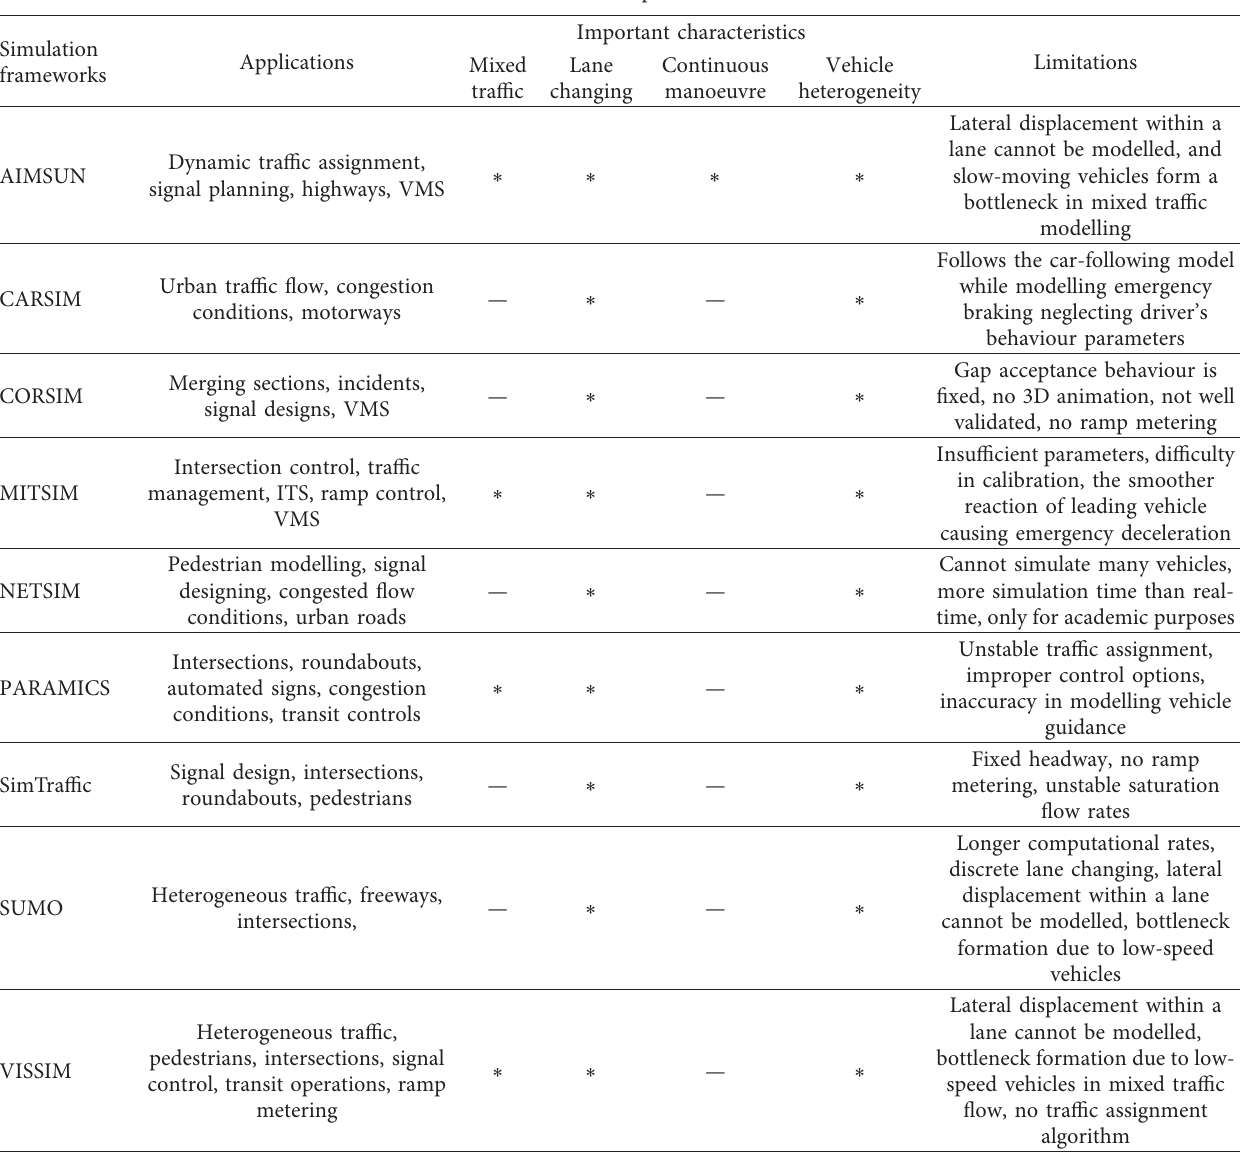
Table 4: Outline of all microscopic simulation